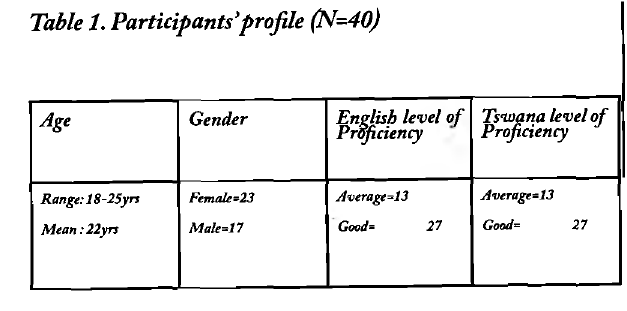
Table 3. Spearman Correlation coefficients and standard